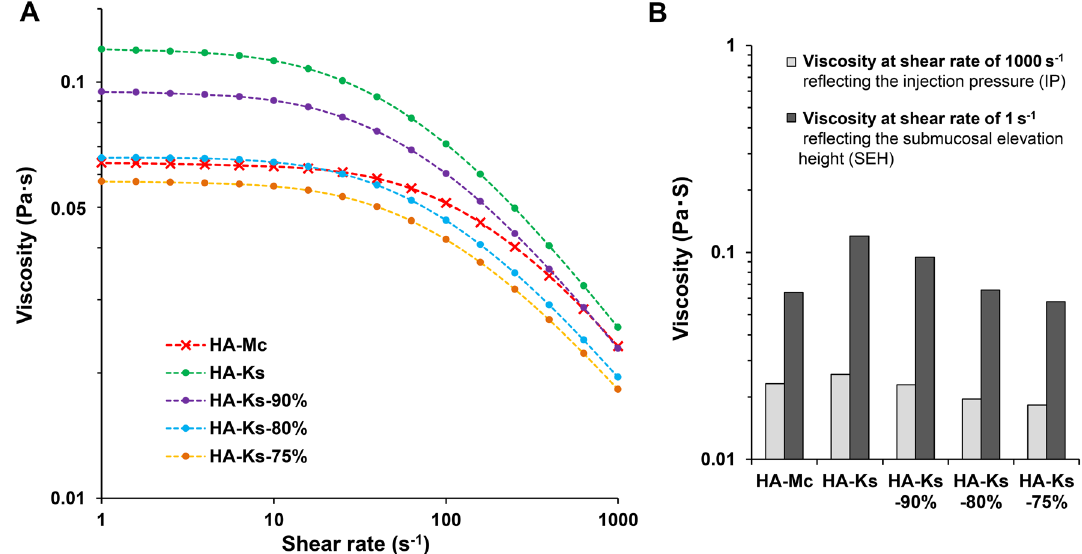
Figure 1. Viscosity analysis for HA-Mc and HA-Ks. ( A ) Viscosity of HA-Mc, HA-Ks, HA-Ks-90%, HA-Ks- 80%, and HA-Ks-75% at each shear rate. ( B ) Comparison of viscosity between HA-Mc and HA-Ks at shear rates of 1 s −1 and 1000 s −1 . Viscosity at shear rates of 1 s −1 and 1000 s −1 most significantly affected the submucosal elevation height and injection pressure, respectively. HA-Mc, sodium hyaluronate-based submucosal injection material (MucoUp); HA-Ks, sodium hyaluronate-based submucosal injection material